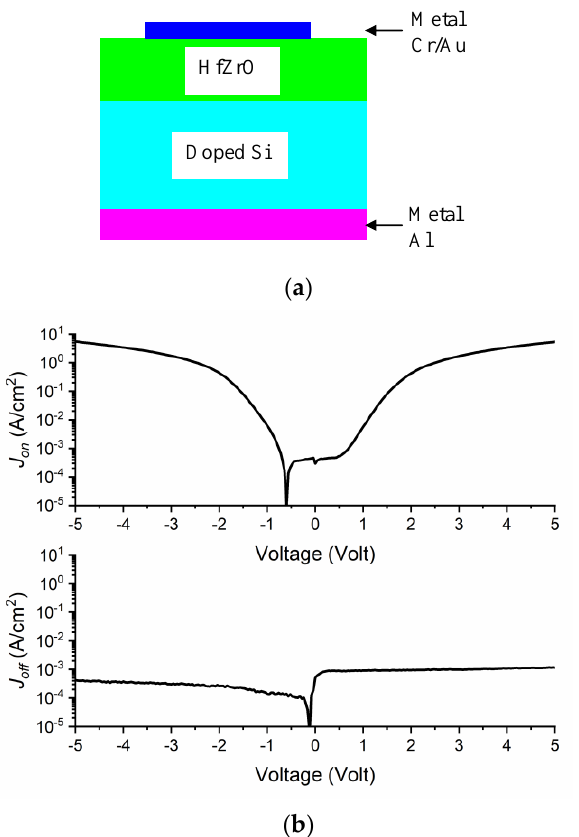
Figure 6. ( a ) Cross-section of the HfZrO-based ferroelectric tunneling junction (FTJ) switch; ( b ) ON (top) and OFF (bottom) current densities as a function of the applied direct current (DC) bias voltage [22].